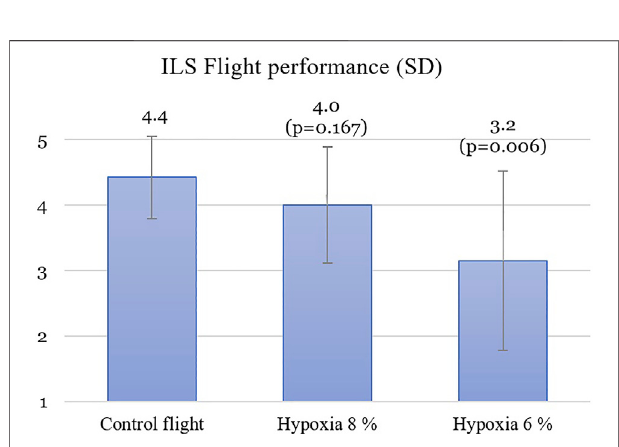
FIGURE4| TheInstrumentlandingsystem fl ightperformanceduringthe return to base.